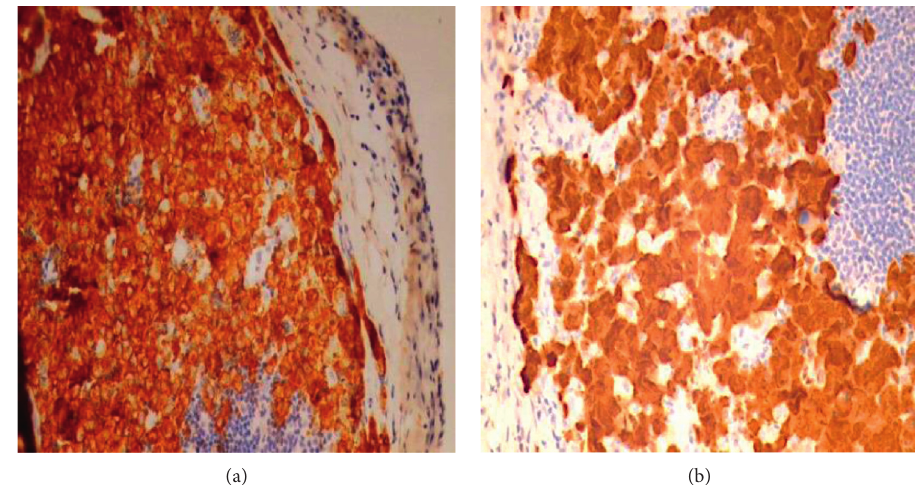
Figure 7: (a) At high magnification, strong, uniform CD 30 positivity in the cytoplasmic membranes and Golgi regions of the neoplastic cells. (b) At high magnification, diffuse cytoplasmic and nuclear staining for ALK.